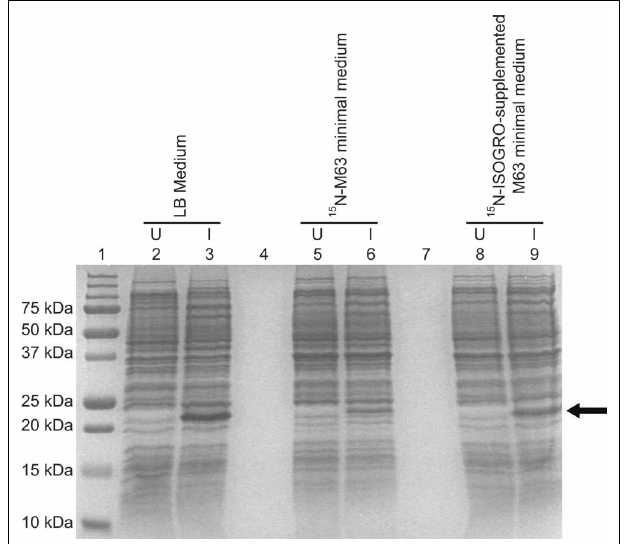
FIGURE 4 | Comparison of theTM4-Cx45CT expression profile obtained from E. coli strain C41(DE3) with the pLysS plasmid in LB and minimal media. C41(DE3)pLysS transformed with theTM4-Cx45CT plasmid was grown in LB medium (lanes 2 and 3), 15 N-labeled M63 minimal medium (lanes 5 and 6), and 15 N-labeled M63 minimal medium supplemented with 1 g 15 N-ISOGRO/L medium (lanes 8 and 9). Lane 1 contains the Precision Plus Protein All Blue Standards molecular mass marker (Bio-Rad) and lanes 4 and 7 are blank. Samples were collected just prior to (uninduced, U) and 4 h after IPTG induction (I), as noted. A total of 500 μ L samples with an Abs 600 nm at 0.5 were pelleted and resuspended in 30 μ L of 6 × SDS loading buffer. Equal amounts of total protein (7 μ L) were ran on a